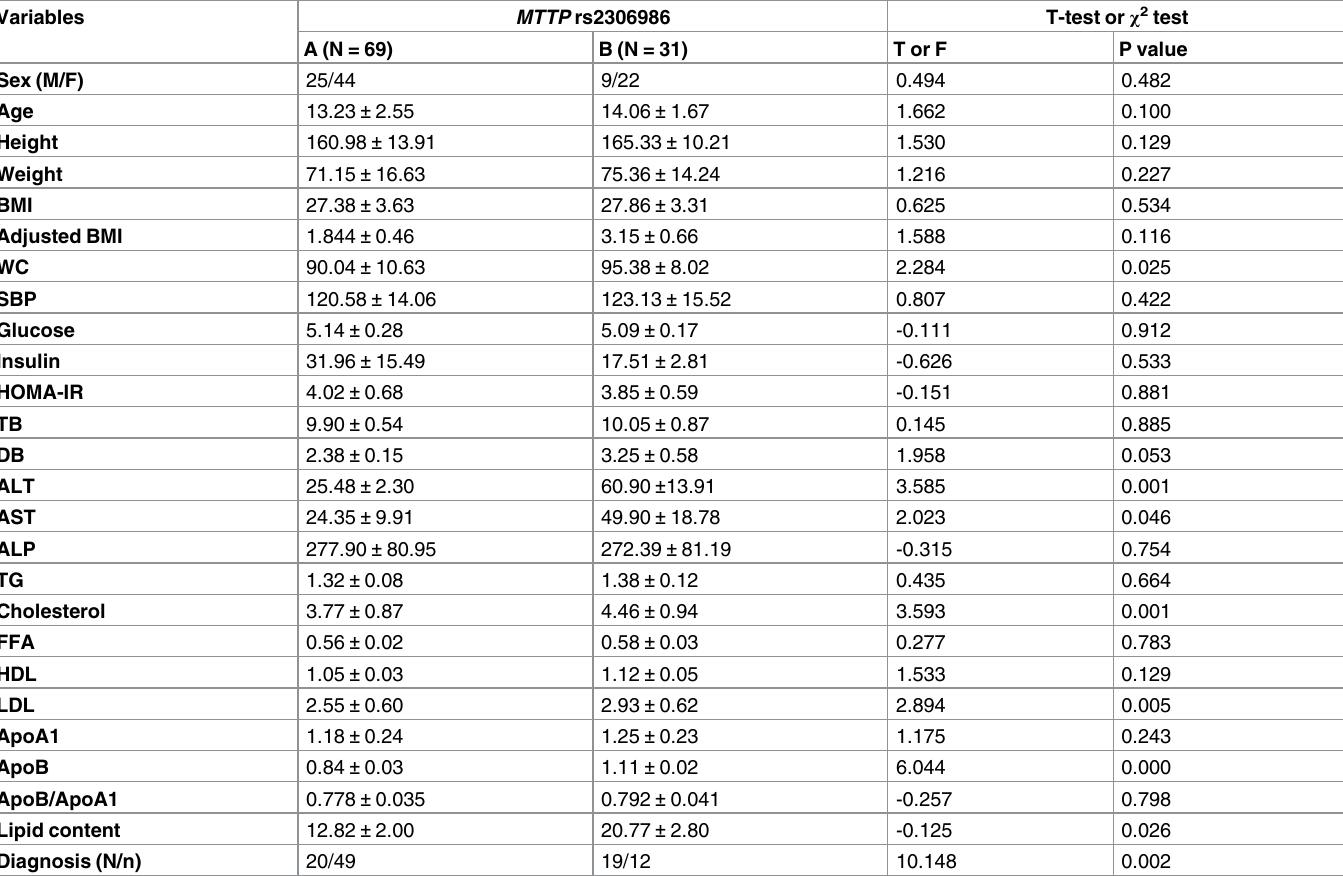
Table 3. The comparison of anthropometric and biochemical characteristics based on the presenceof variation of MTTP rs2306986(subjects of Han Chinese ethnicity).